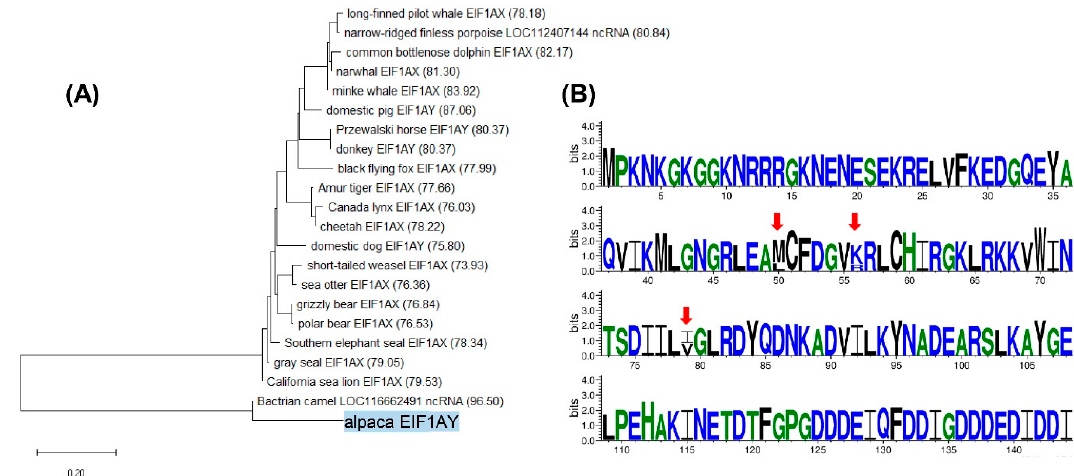
Figure 6. Comparative analysis of alpaca EIF1AY . ( A ) Neighbor-joining nucleotide tree showing the closest related sequences to the alpaca EIF1AY in Genbank as revealed by BLAST. Branch length is equivalent the relative distance between sequences. ( B ) Logographical representation of amino acid sequence conservation between human, mouse, and zebrafish orthologs of alpaca EIF1AY as revealed by smartBLAST. Residues at each position are scaled according to their frequency (y-axis; bits). The x-axis shows amino acids and their sequence positions. Residues are colored according to their biochemical properties: hydrophilic in blue, neutral in green, and hydrophobic in black. Positions with a single letter denote conservation across all species. Variable amino acids are indicated by red arrows and the size of the two letters in these positions is proportional to their occurrence across all